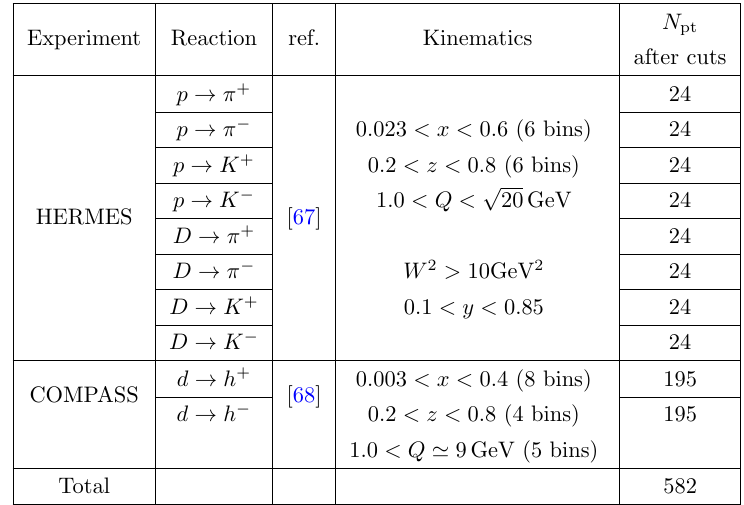
Table 2 . Summary of the SIDIS data included in the (cid:12)t. For each data set we report reference, reaction, kinematic region, and number of points that are left after the application of consistency cuts in eq. (3.1),